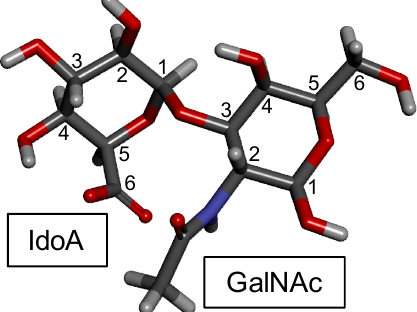
Figure 2. Representative disaccharide unit, GlcA( β 1 − 3)GalNAc, of CS backbones in the 3D stick model. Hydrogens, carbons, oxygens and nitrogens are respectively represented in light grey, dark grey, red and blue. Carbon atoms are numbered according to their positions in the ring. Monosaccharides are indicated accordingly. Model created by the online AMBER/GLYCAM-based carbohydrate builder [40].